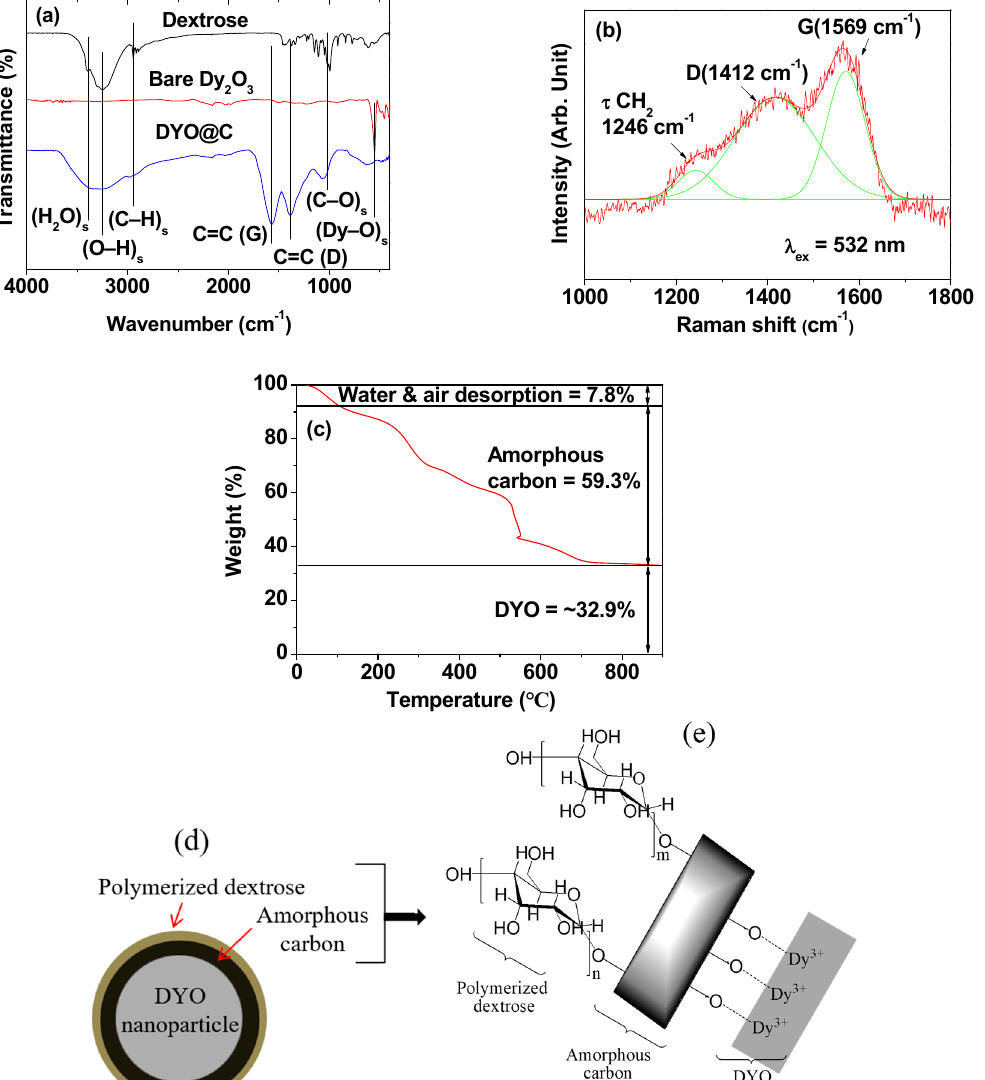
Figure 3. ( a ) FT-IR absorption spectra of the free dextrose (top spectrum), bare Dy 2 O 3 nanoparticles (middle spectrum obtained after TGA), and DYO@C nanoparticles (bottom spectrum); ( b )